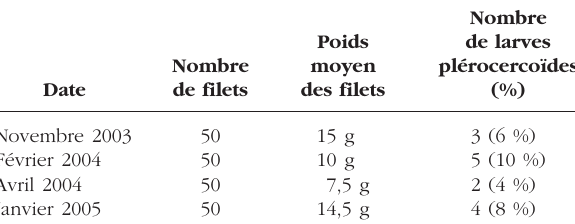
Nombre Poids de larves Nombre moyen